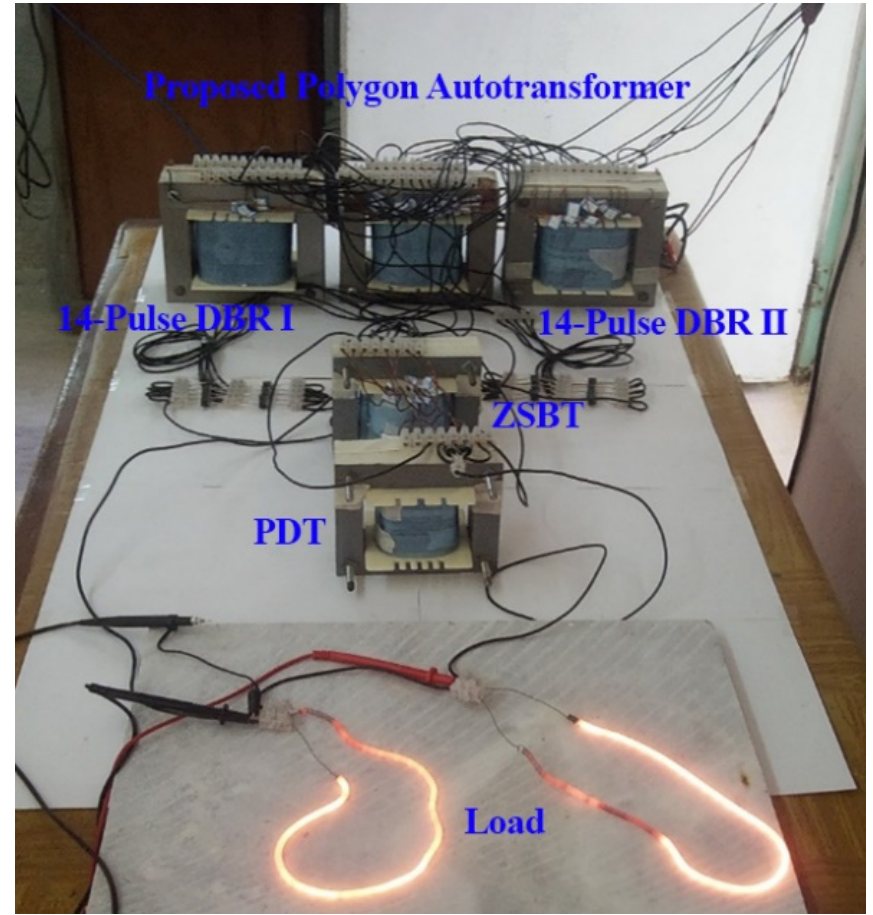
Figure 8. The experimental setup of the 56-PR based on PCA and PDT.